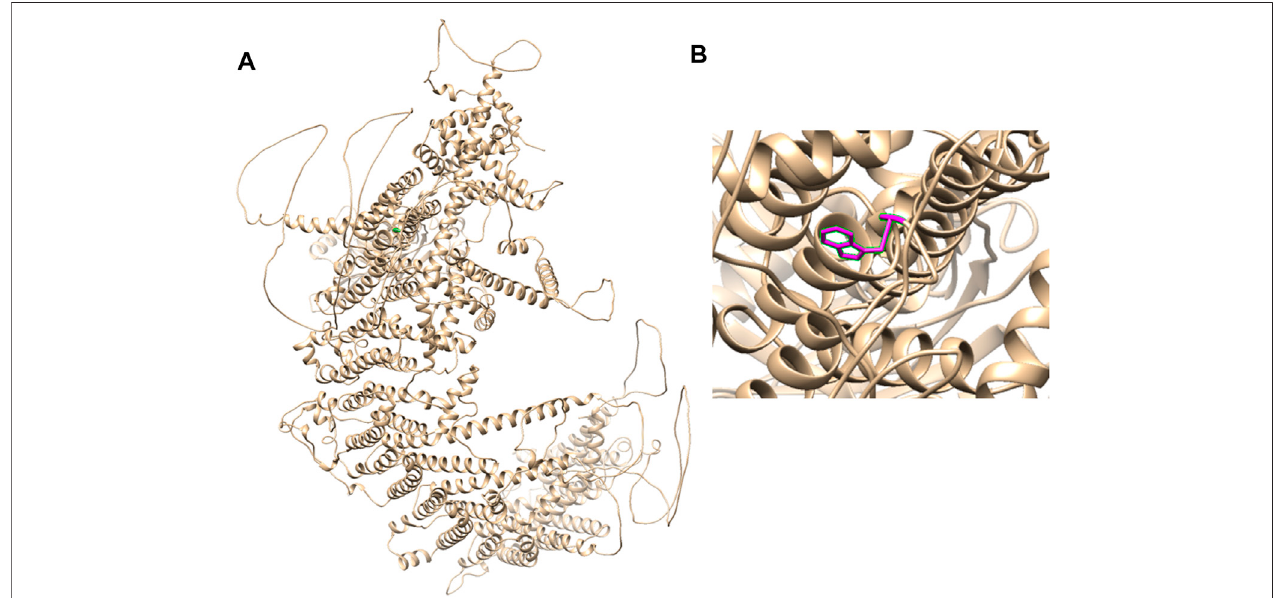
FIGURE 4 | 3D modeling of PIEZO1 p.Ser1721Trp. (A) Ribbon modeling of PIEZO1 (1 – 2,521). (B) Close-up of PIEZO1 p.Ser1721Trp is depicted in magenta.